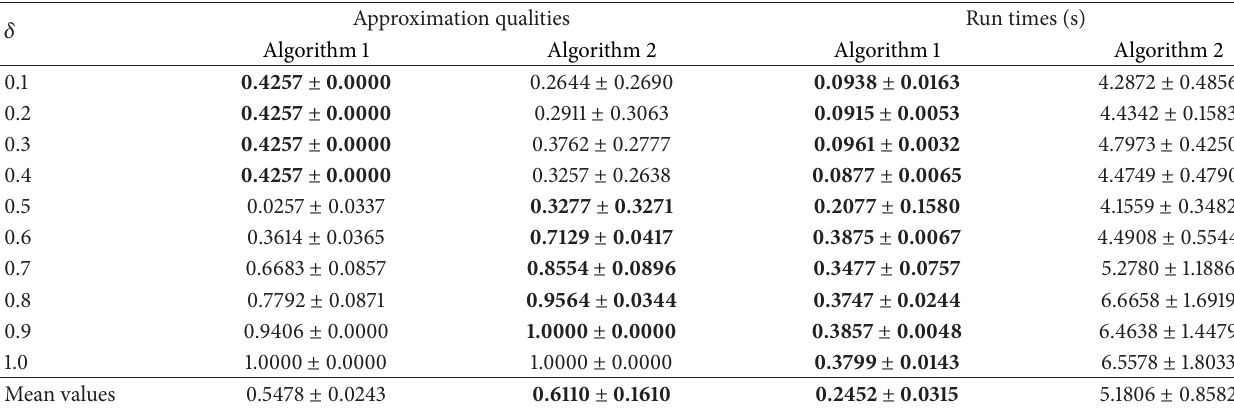
Table 9: The comparison between decision-monotonicity criterion based reducts and cost based reducts